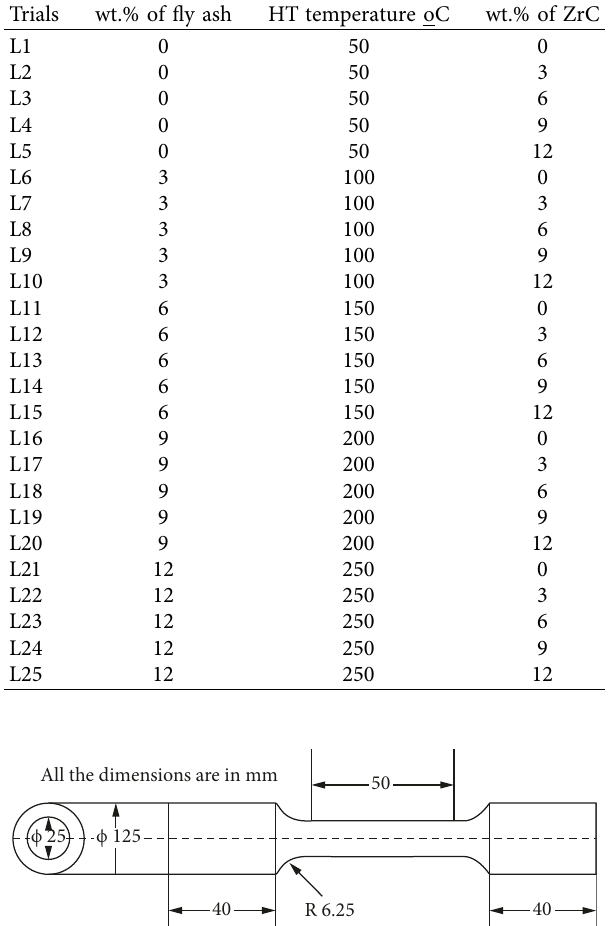
Table 4: Experimental conditions for different